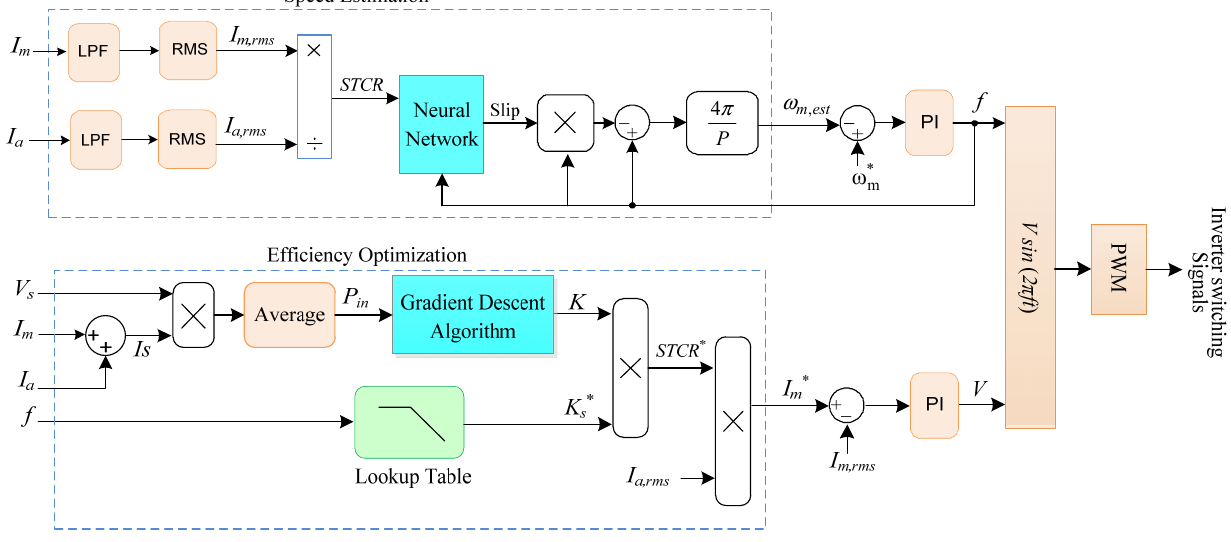
Figure 4. Block diagram of the proposed control scheme.